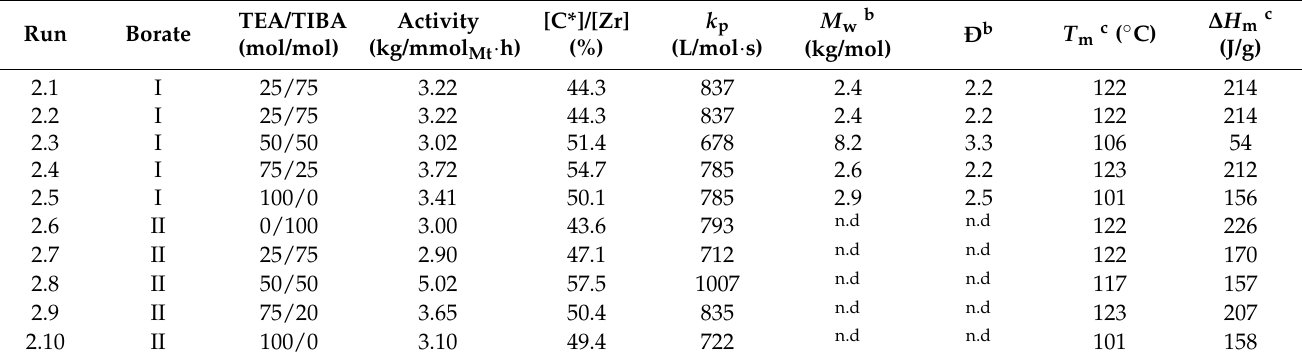
Table 2. Results of ethylene polymerization with Mt-II a